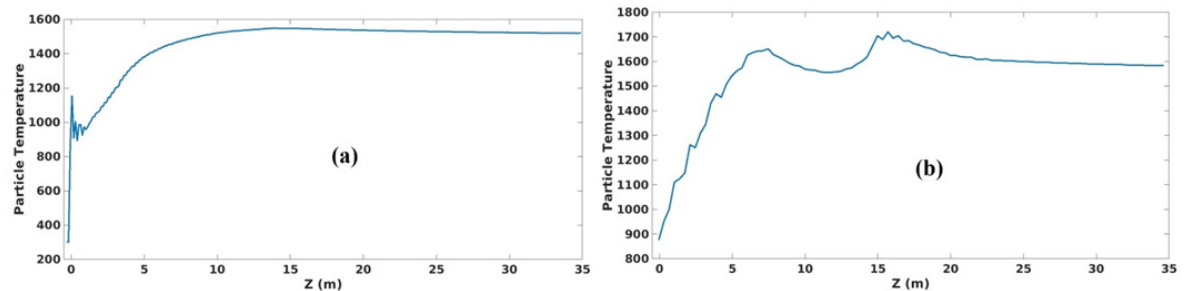
Figure 33. Mass weighted average mass fraction of metallic iron in particles: ( a ) Reactor 1 and ( b ) Reactor 2.